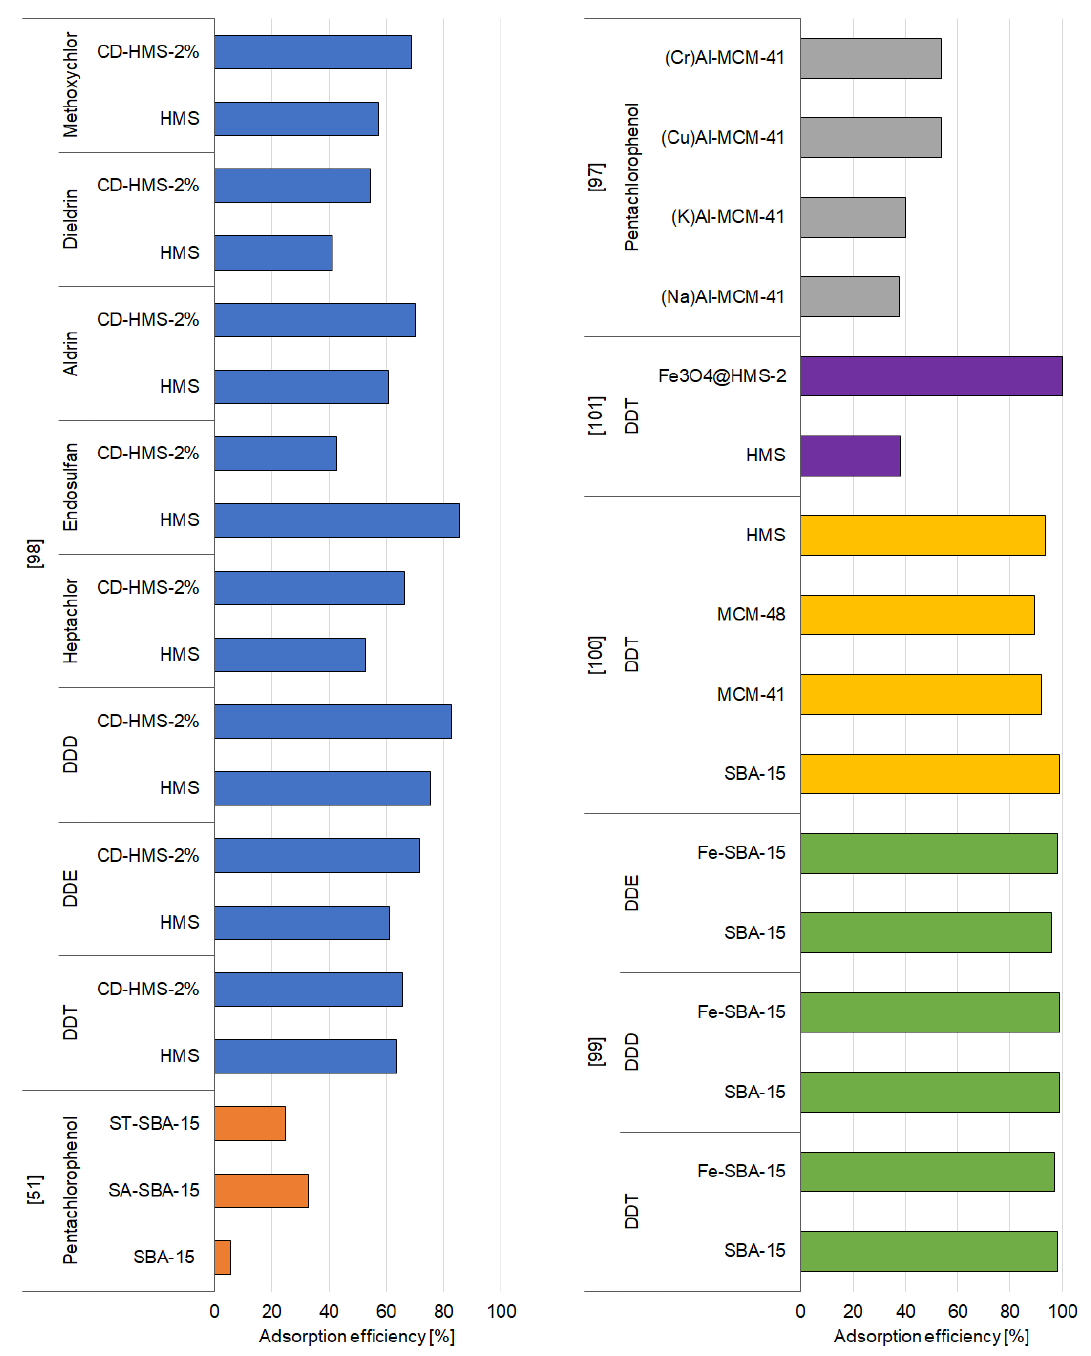
Figure 2. Effectiveness of removal of organochlorine pesticides by mesoporous silica materials.